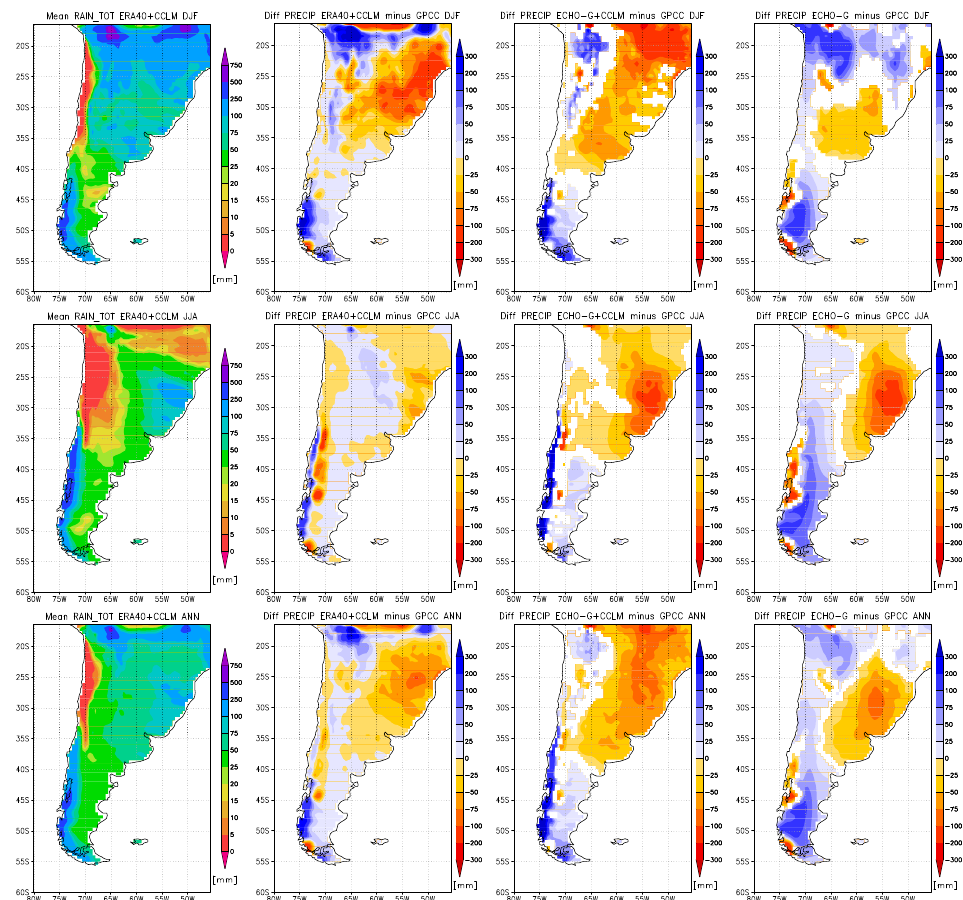
Fig. 4. Same as Fig. 3 except for precipitation based on the GPCC Figure 4 : same as Figure 3 except for precipitation based on the gridded GPCC data set.